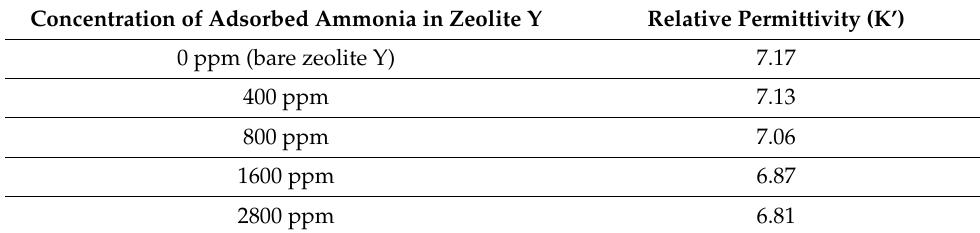
Table 3. Relative permittivity of zeolite Y at 3